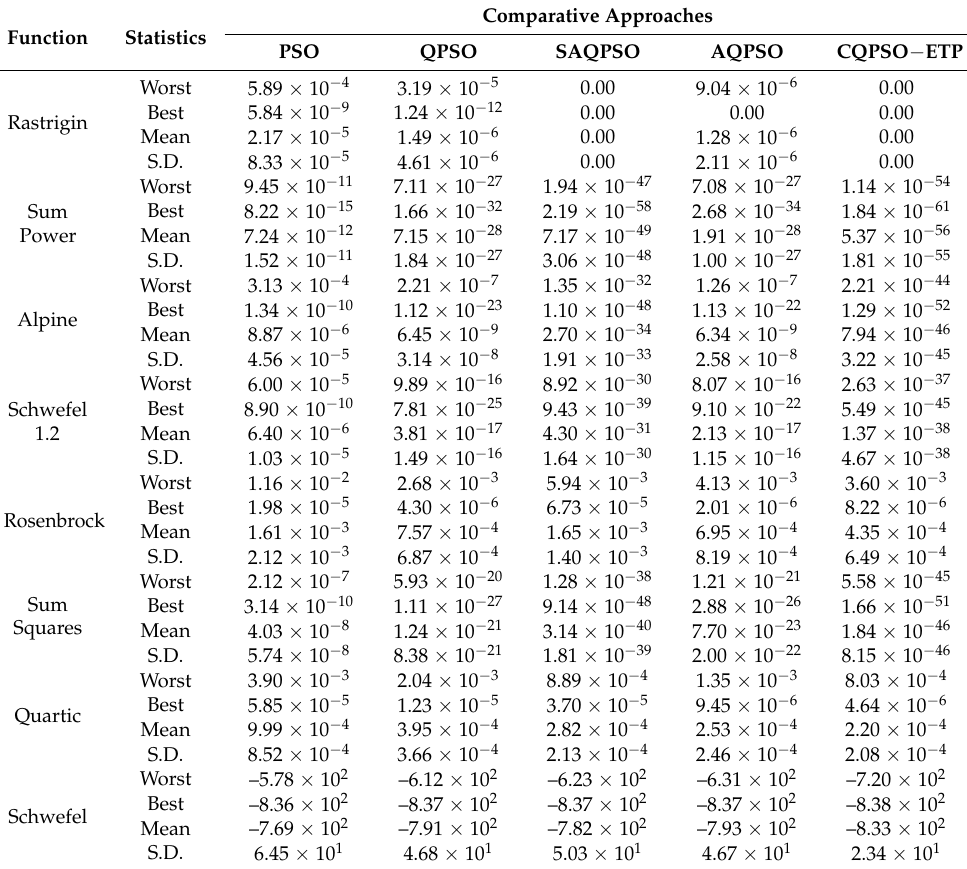
Table 3. Computational results of the comparative approaches on eight numerical benchmark functions ( D =